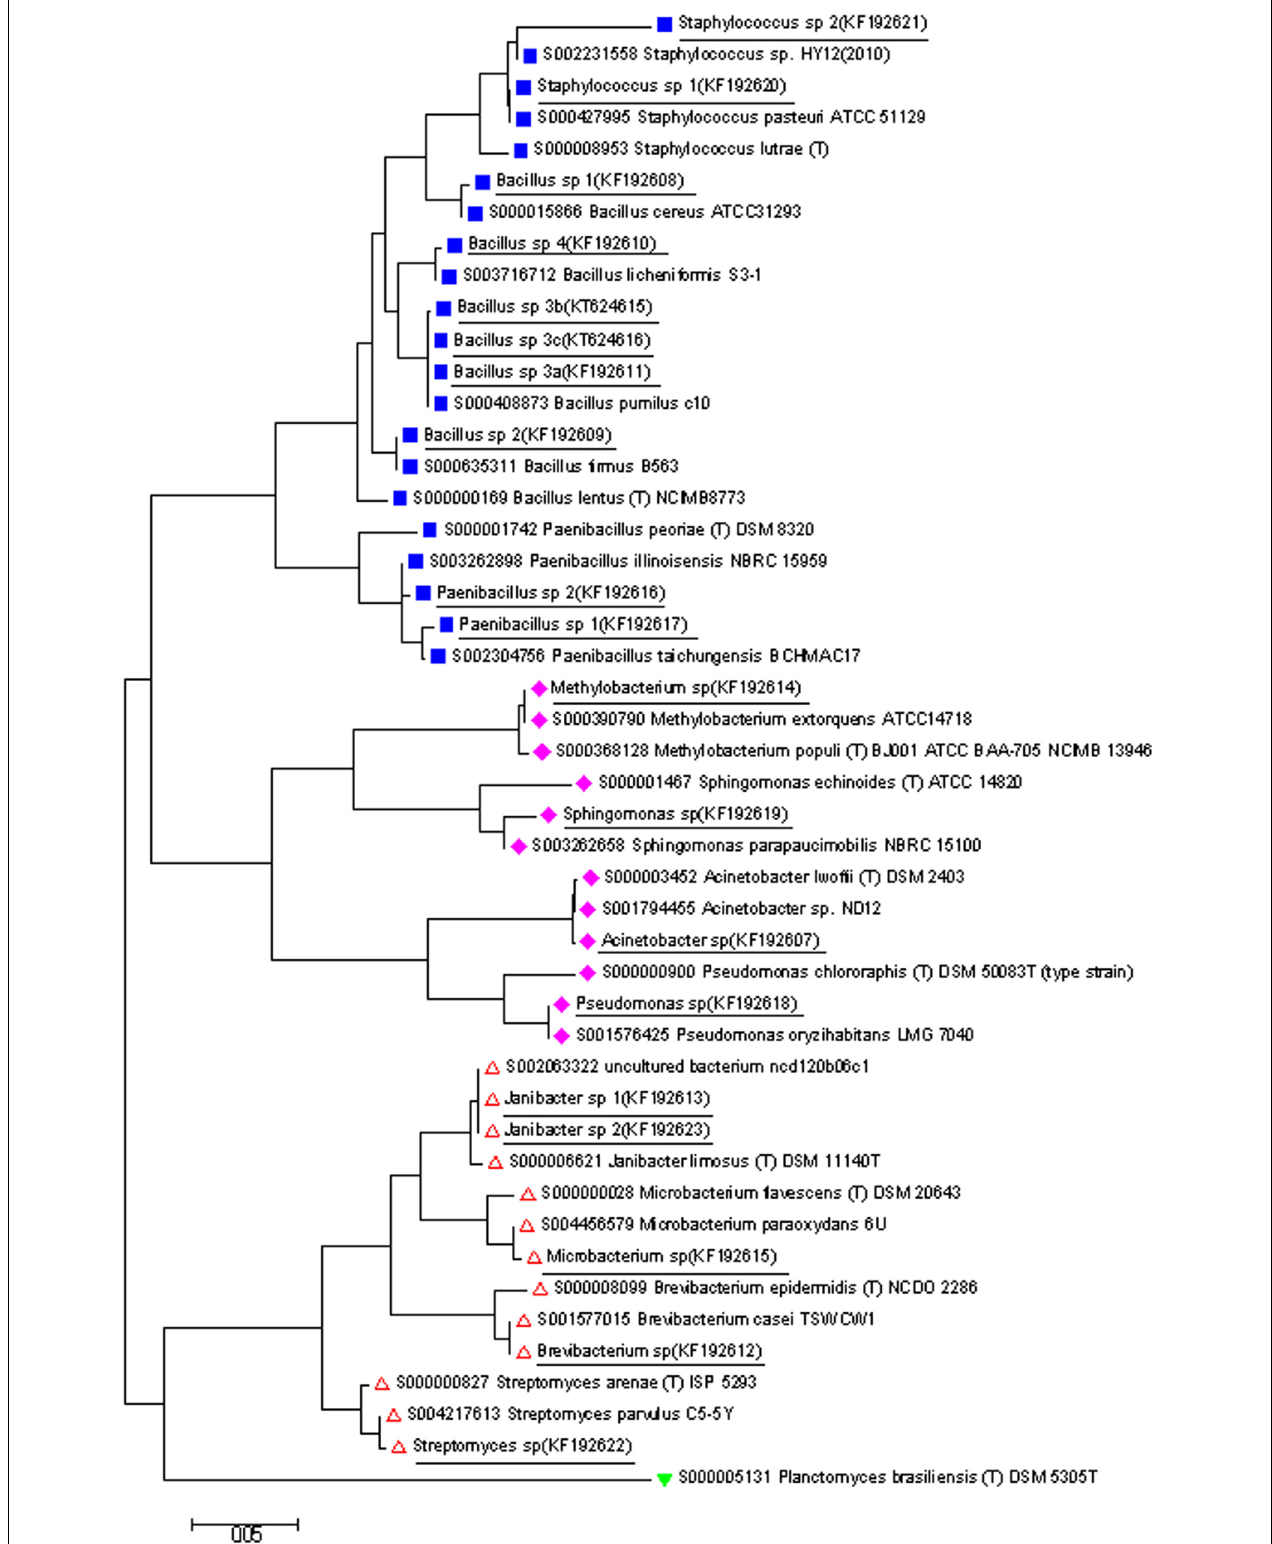
FIGURE 3 | A phylogenetic tree based on the 16S rDNA gene sequences from isolates determined in this study (shown underlined), and closely related 16S sequences from isolates available from RDP database. The tree was generated by Neighbor Joining method in Mega. Phylum groups: (cid:4) Firmicutes, (cid:7) Proteobacteria, (cid:49) Actinobacteria, and (cid:72) Planctomycetes (out group).